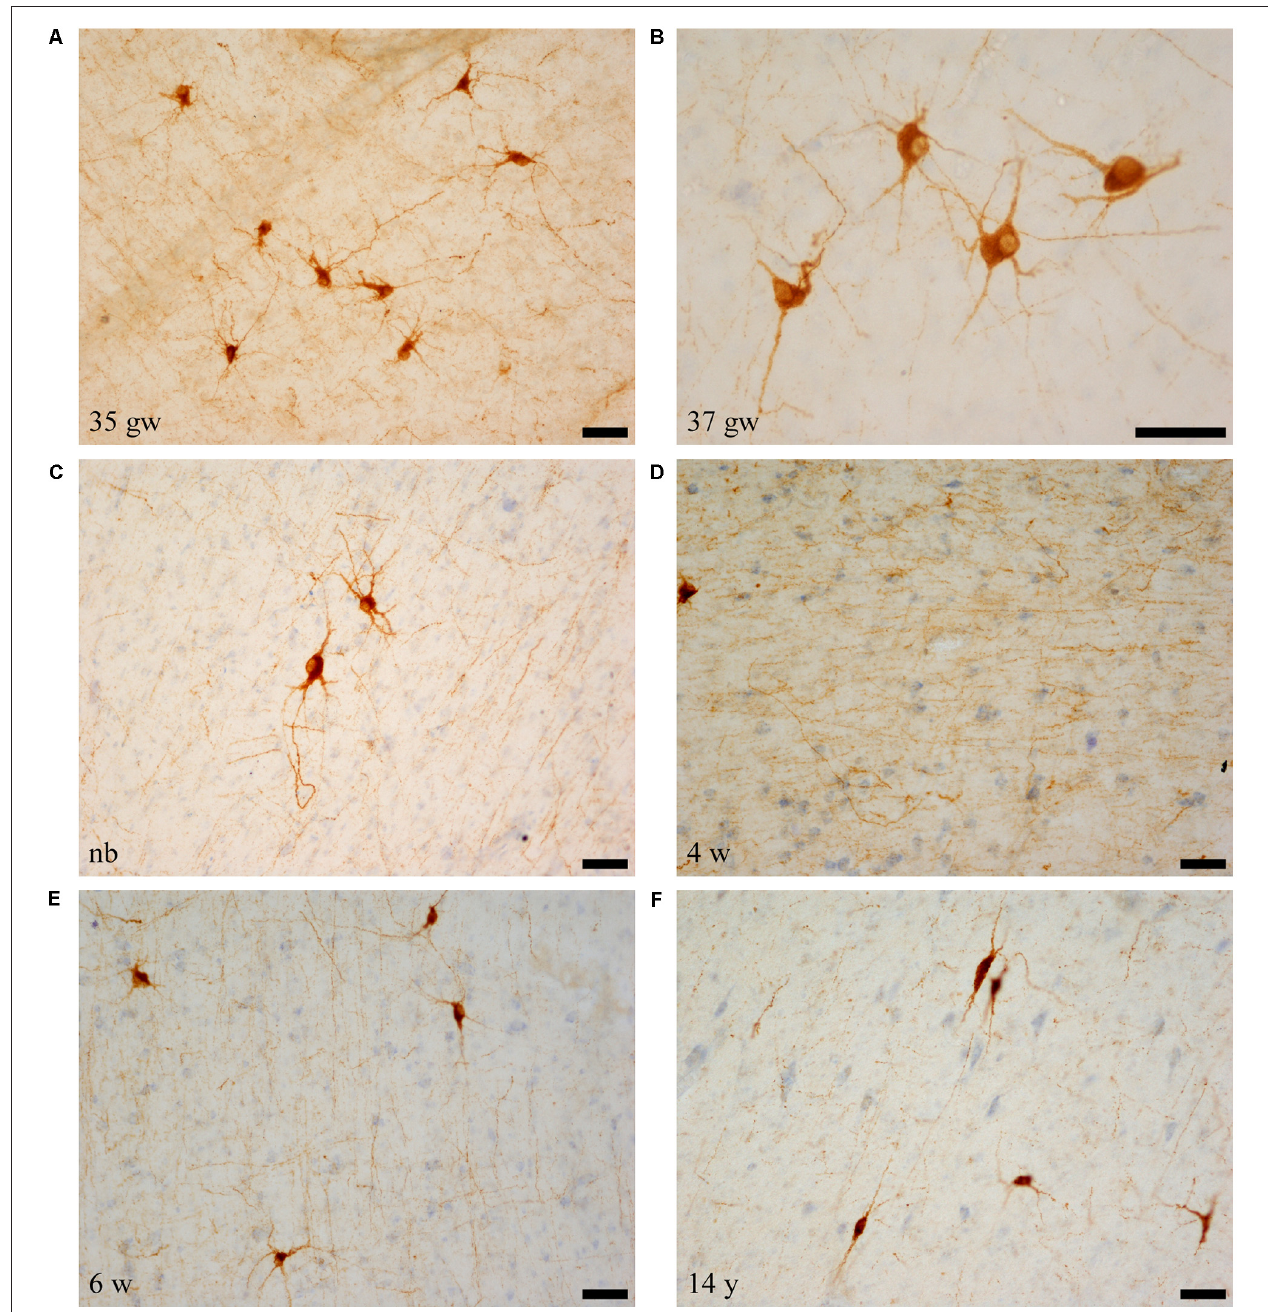
FIGURE 1 | Microphotographs of neuropeptide Y (NPY)-immunoreactive neurons and fibers at different ages. Panels (A–C) are the youngest cases (35–40 weeks), which show maximal amount of neuron and fiber immunoreaction. Most NPY-positive neurons are polygonal in shape. Panel (D) shows NPY-immunoreactive fibers, and panel (F) shows spindle shaped neurons at 14 years (730 weeks). In relation to the topography of the hippocampus, (A,D,F) are from rostral levels, (C) is midlevel, and (B,E) are at caudal levels. Scale bar is 50 µ m.